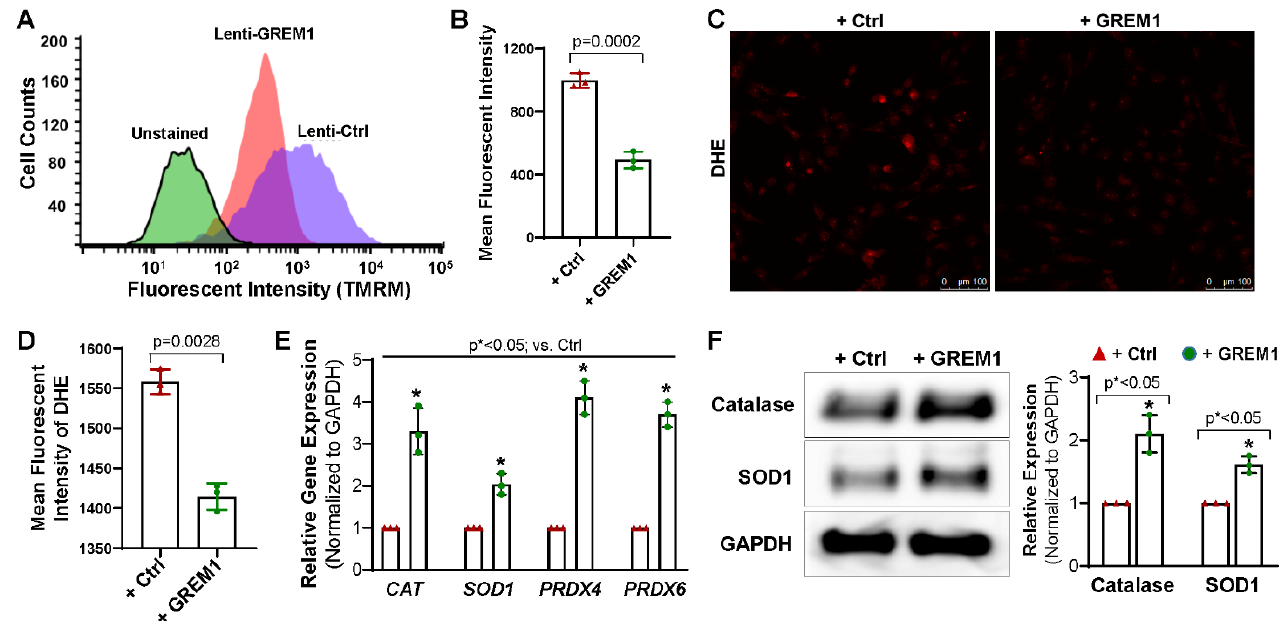
Figure 4. Overexpressing GREM1 decrease the ROS generation in hMPCs and increase the expression of antioxidant proteins. ( A ) Representative merged histogram for mitochondrial ROS measurement for aged hMPCs overexpressing GREM1 vs. vector control by FACS analysis following TMRM live cell staining. ( B ) Quantitative analysis for panel A. ( C ) Representative images for DHE staining for aged hMPCs infected with GREM1 or vector lentivirus for 48 h. ( D ) Quantitative analysis for C. ( E ) Real-time quantitative PCR analysis with an antioxidant primer library screening shows the increased gene expression of CAT, SOD1, PRDX4, and PRDX6 in hMPCs with GREM1 overexpression. ( F ) Representative images and quantitative data of Western blot showing the expression level of antioxidant proteins (catalase and SOD1) after GREM1 was overexpressed. Full-length blots are presented in Supplemental Figure S2. Data are mean ± SEM. p value was calculated by unpaired Student’s t -test, n = 3 independent experiments. * indicated the significant difference compared to the control group.